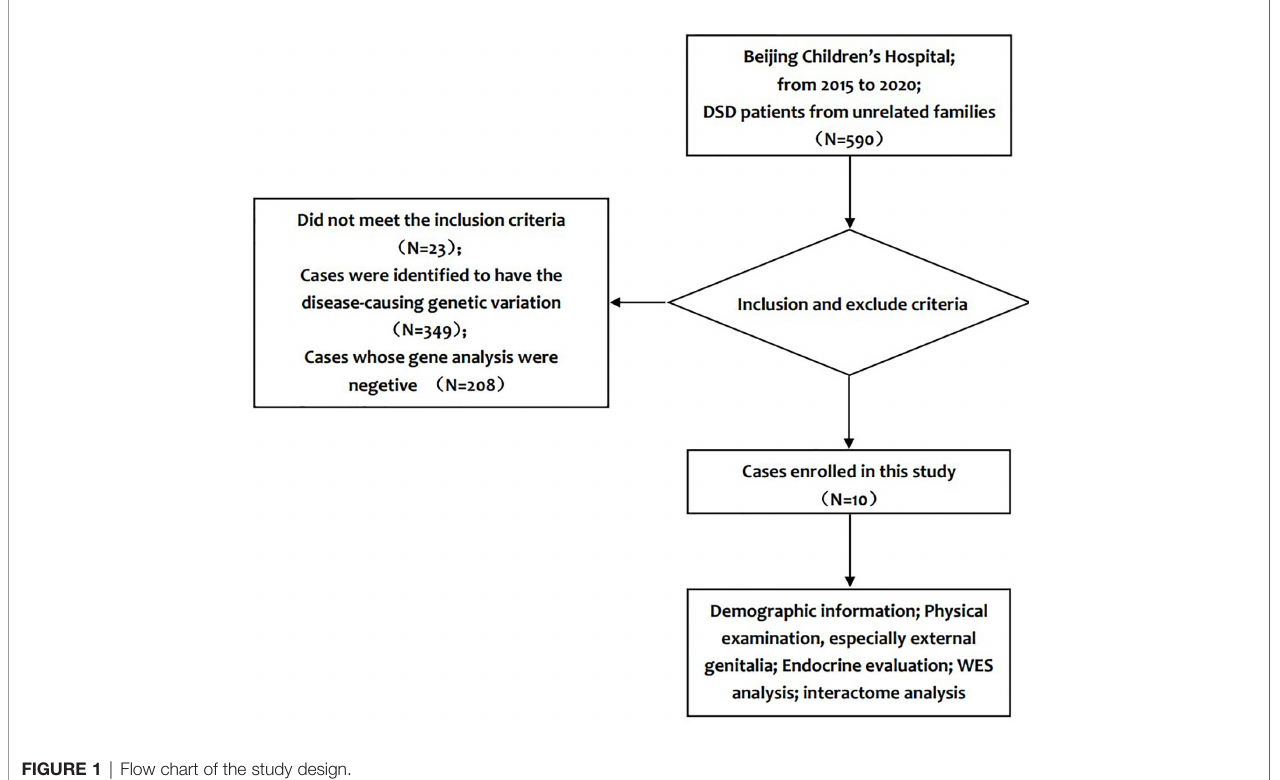
FIGURE 1 | Flow chart of the study